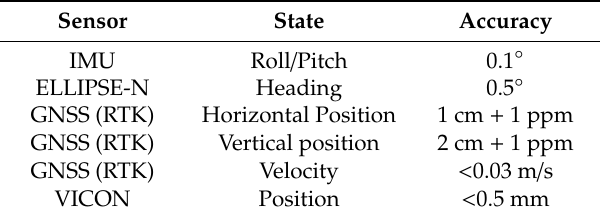
Table 1. Comparison of the accuracy of di ff erent